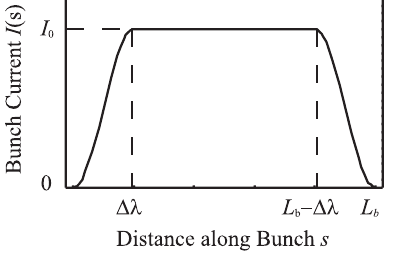
FIG. 12. The bunch current at the undulator entrance as a function of the distance along the bunch.